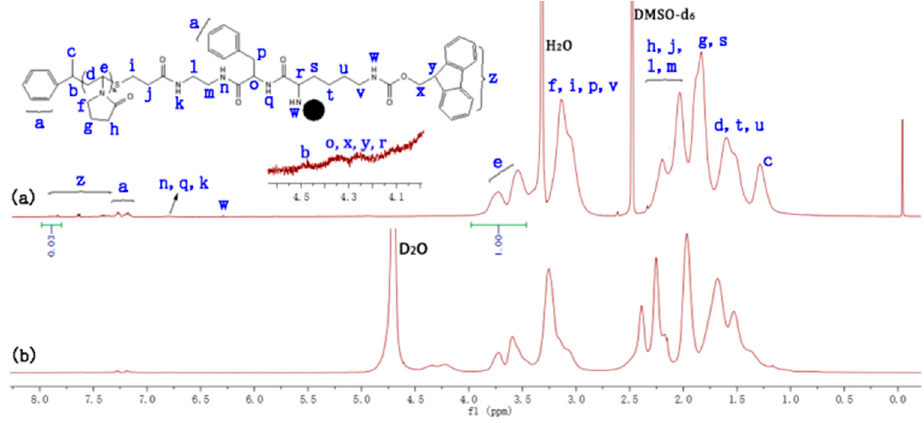
Figure 1. 1 H NMR spectra of PNVP- b - dendr (Phe-Lys) in DMSO-d 6 ( a ) and D 2 O ( b ).